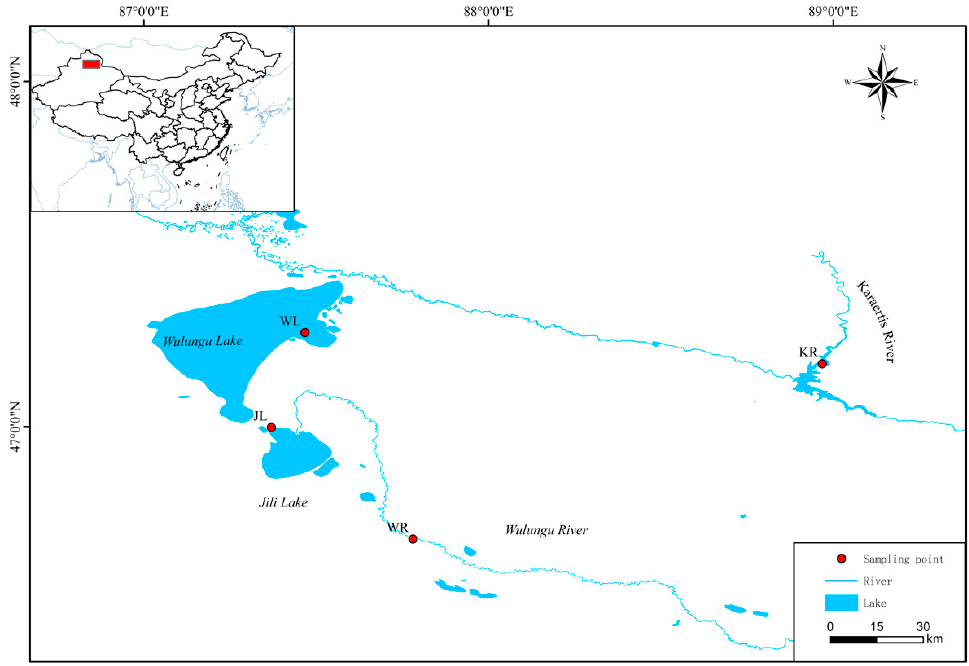
Figure 1. Sampling distribution of four P. fluviatilis populations. WL: Wulungu Lake; JL: Jili Lake; WR: Wulungu River; KR: Kalaeerqisi River.